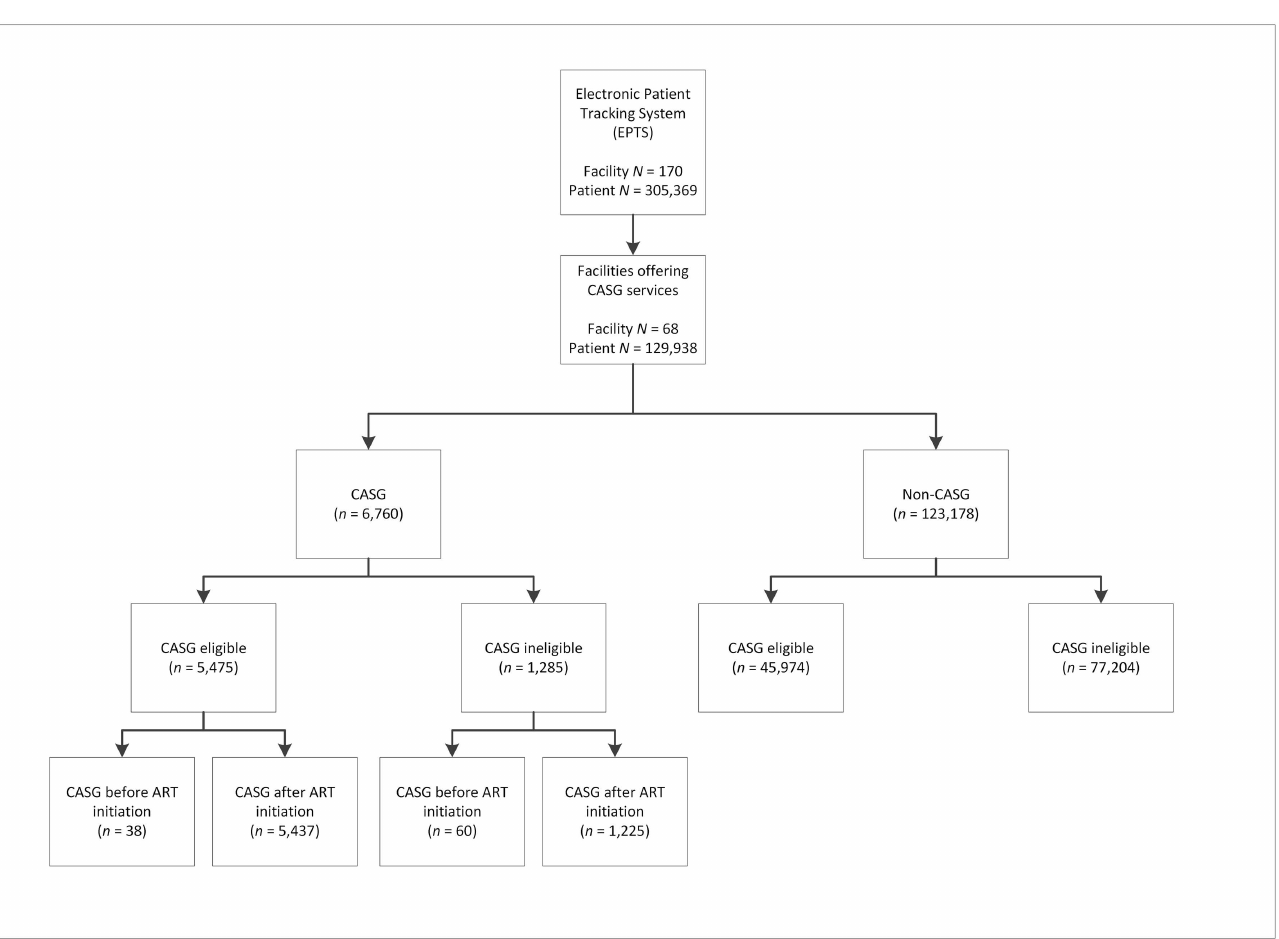
Fig 1. Study flow